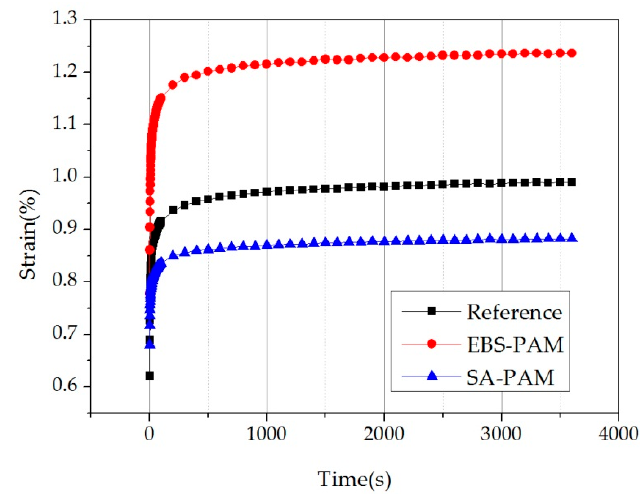
Figure 9. The creep curves of the three mixtures.